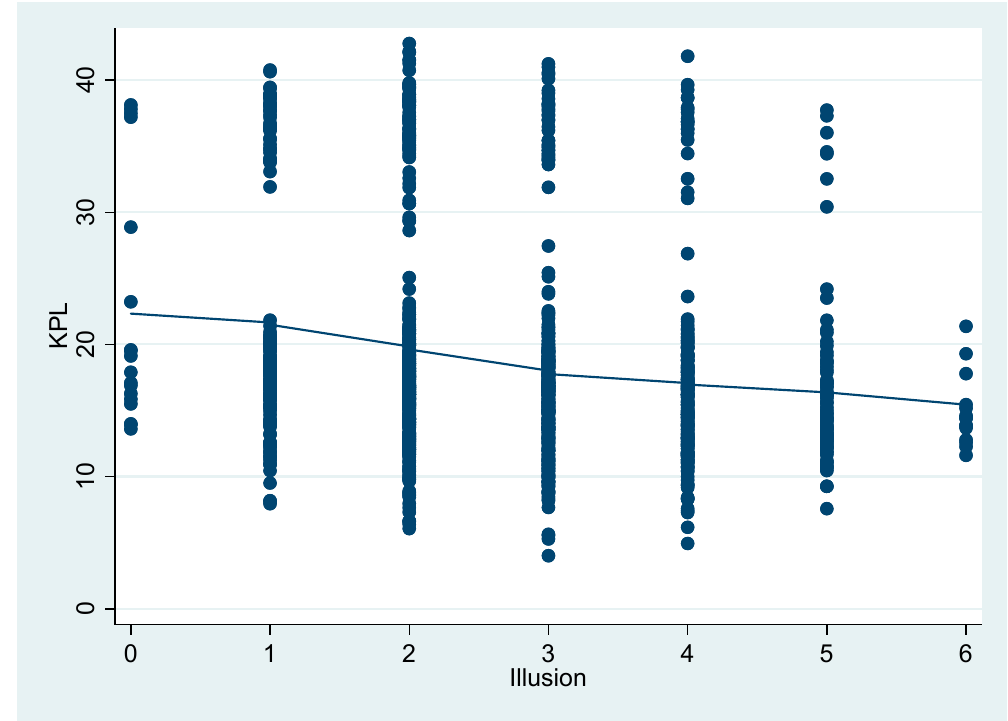
Figure 2. Semiparametric estimation result. Note: A model fit test, which compares the deviation between the full model and the model without smooth term, shows significant value. (significant at 0.5% level). For the sake of saving space, the estimation results of the other linear parametric variables are shown in Appendix B.